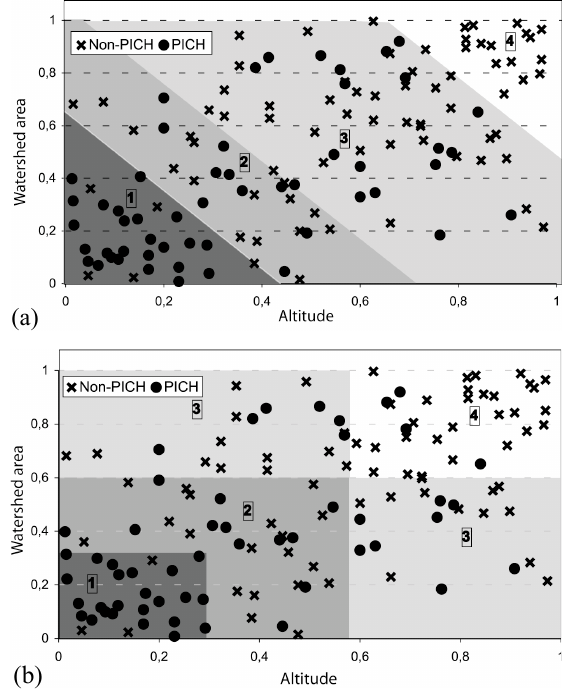
Fig. 4. Illustration of the separation of a data set into four classes based on a combination of two factors, the coverage of the classes 1 to 4 appear in grey gradation: (a) thresholds limiting the classes equal to a linear combination of factors and (b) combination of thresholds with connectors “and” (classes 1, 2 and 4) and “or” (class 3).